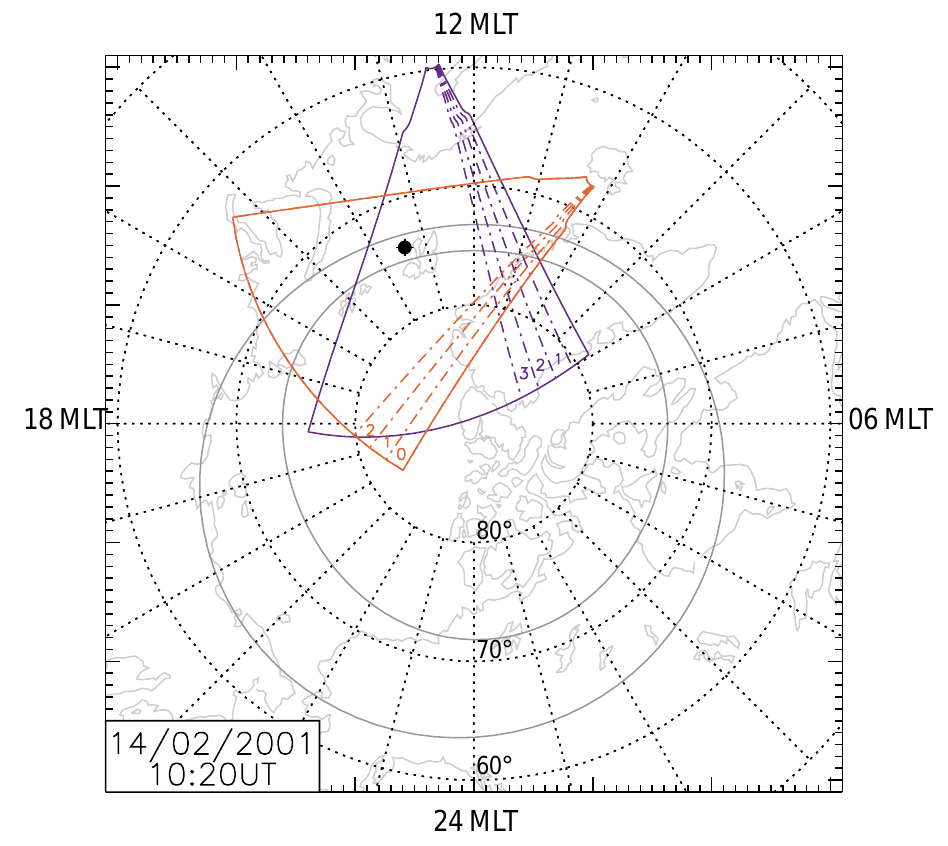
Fig. 1. A magnetic latitude-magnetic local time projection of the Northern Hemisphere at 10:20 UT on 14 February 2001. Lines of constant geomagnetic latitude, starting at 80 ◦ N and then at 10 ◦ intervals, are indicated by dotted concentric circles. Magnetic local time meridians at 1h intervals are also indicated by dotted lines with magnetic noon (midnight) located at the top (bottom) of the figure and dawn (dusk) located on the right- (left-) hand side. The Northern Hemisphere coastlines at this time are indicated in light grey and the statistical location of the auroral oval ( K p = 4) by solid dark grey lines. The overall field-of-view of the SuperDARN Finland radar is shown by the solid indigo lines. The individual beams within the field-of-view referred to in the text are bounded by dot-dashed lines and numbered appropriately. Similarly, the field-of-view and specific beams of the Southern Hemisphere SuperDARN Syowa East radar, mapped into the Northern Hemisphere, are also indicated by red solid and dot-dashed lines, respectively. The Northern Hemisphere ionospheric footprint of the Cluster 1 spacecraft at this time is indicated by the crossed